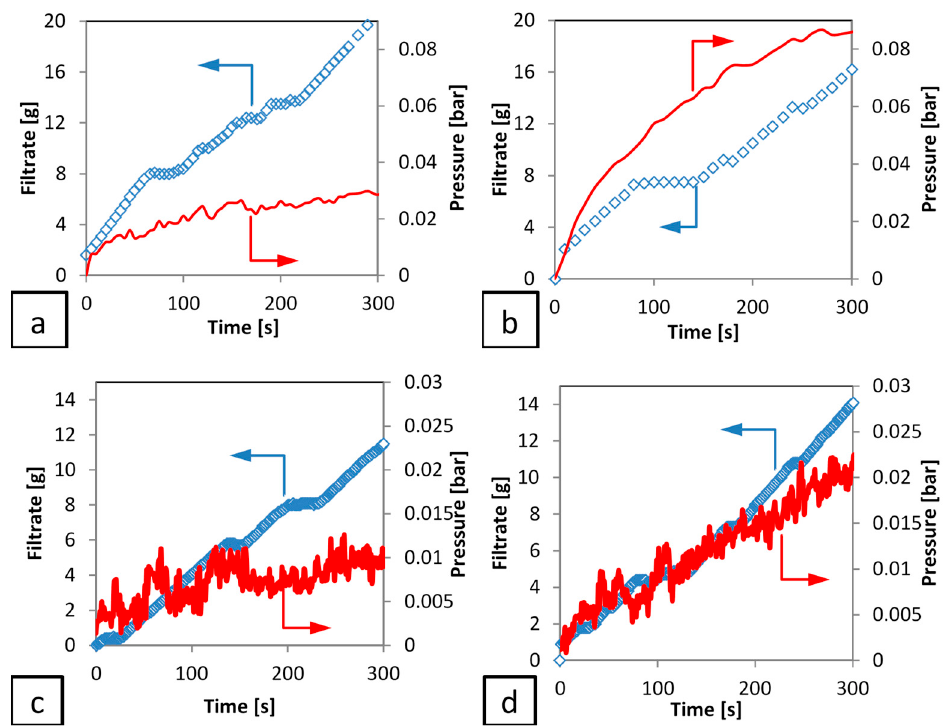
Figure 6. The initial stages of filtration test for talc, ( a ) 0.01 and ( b ) 0.05 ( v / v ), and for calcium carbonate, ( c ) 0.09 and ( d ) 0.21 ( v / v ), at 5 rpm pump speed.